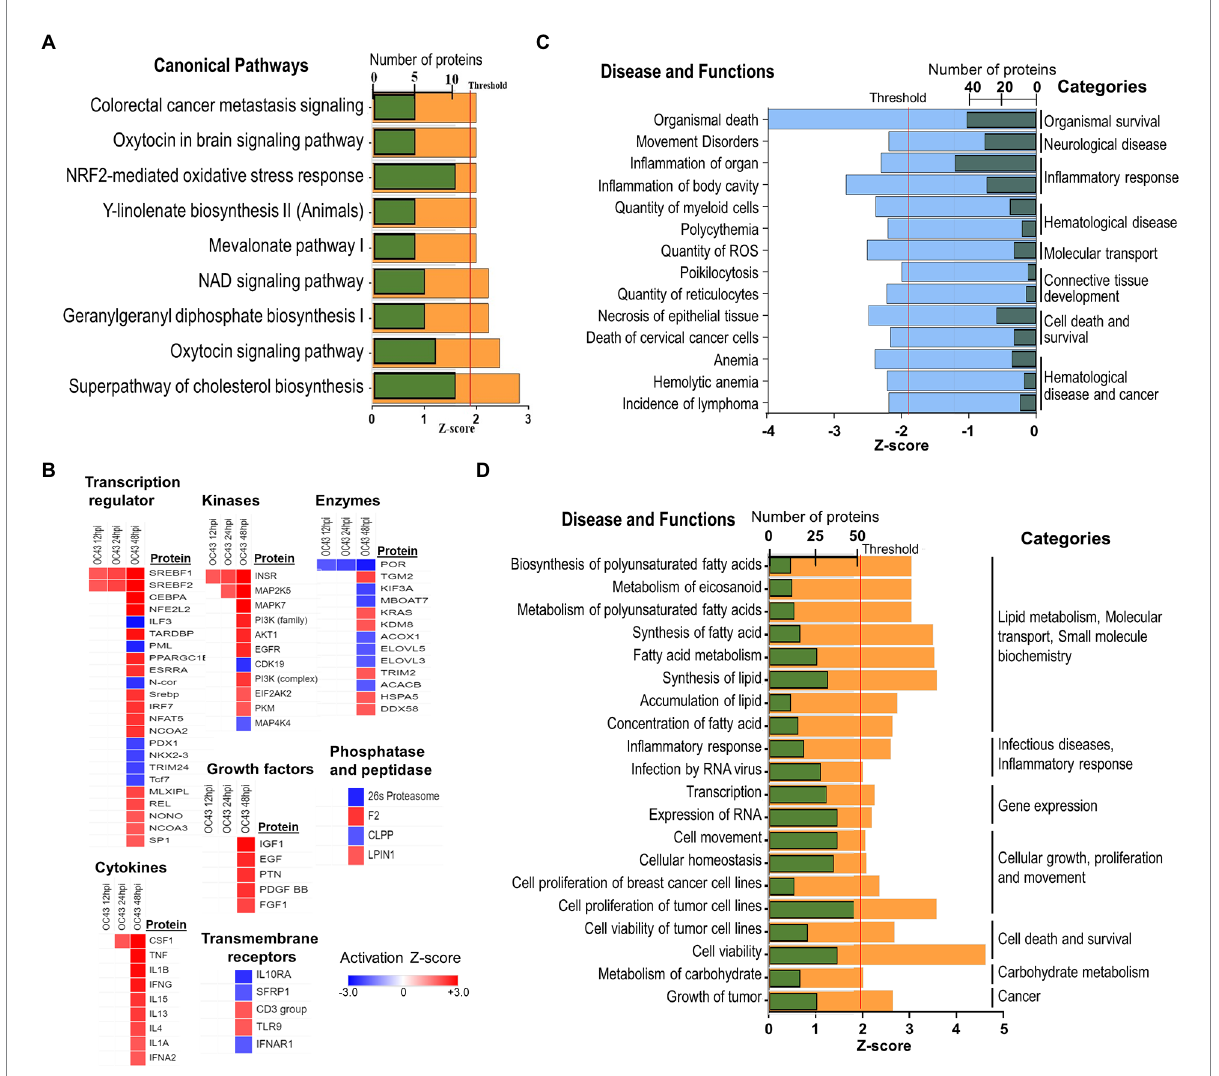
FIGURE 5 (A) IPA predicted activation and inhibition of canonical pathways by OC43 infection at 48 hpi. Green bars represent numbers of molecules significantly dysregulated in each pathway, with Z-score (orange) threshold set at +1.96 σ . (B) IPA predicted activation and inhibition of